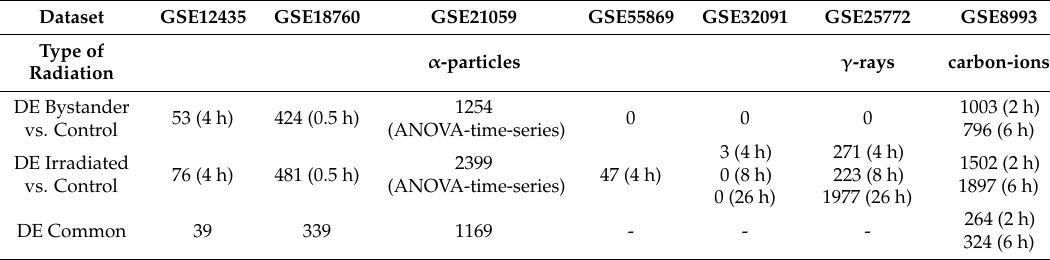
Table 1. Numbers of differentially expressed genes (DE) resulting from statistical testing using